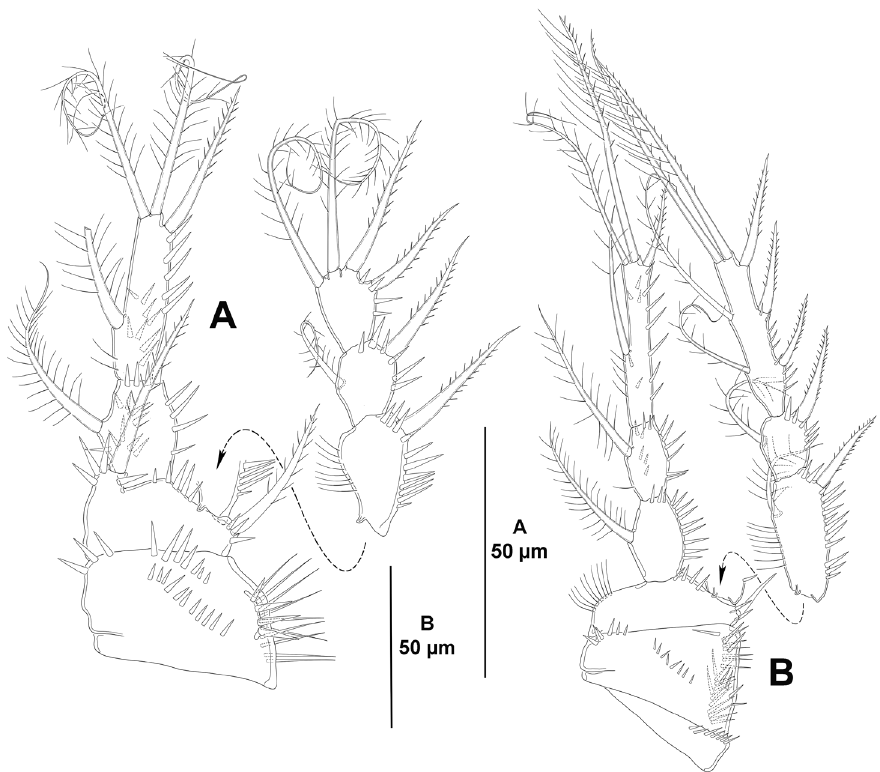
Figure 13. Odiliacletodes secundus sp. n., female holotype. A P1, anterior B P2,